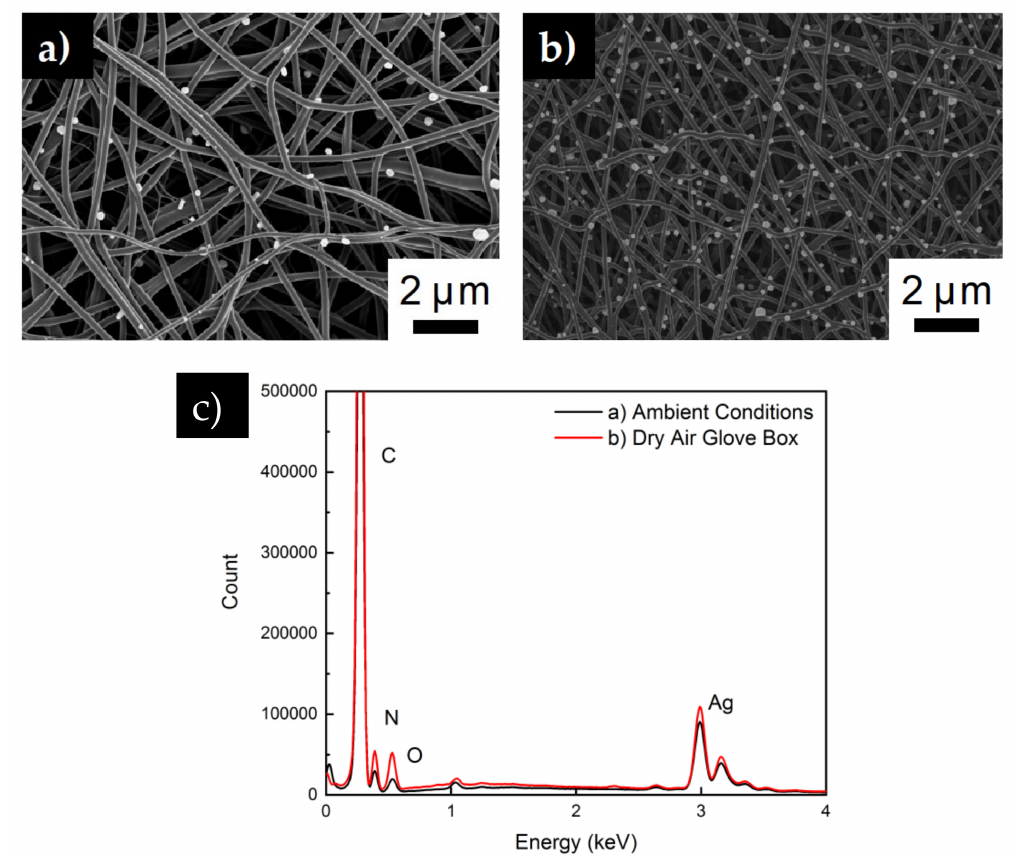
Figure 4. ( a ) SDCNF spun under ambient conditions ( b ) SDCNF spun in a glove box with dry air being constantly pumped through ( c ) EDX spectra of previously mentioned